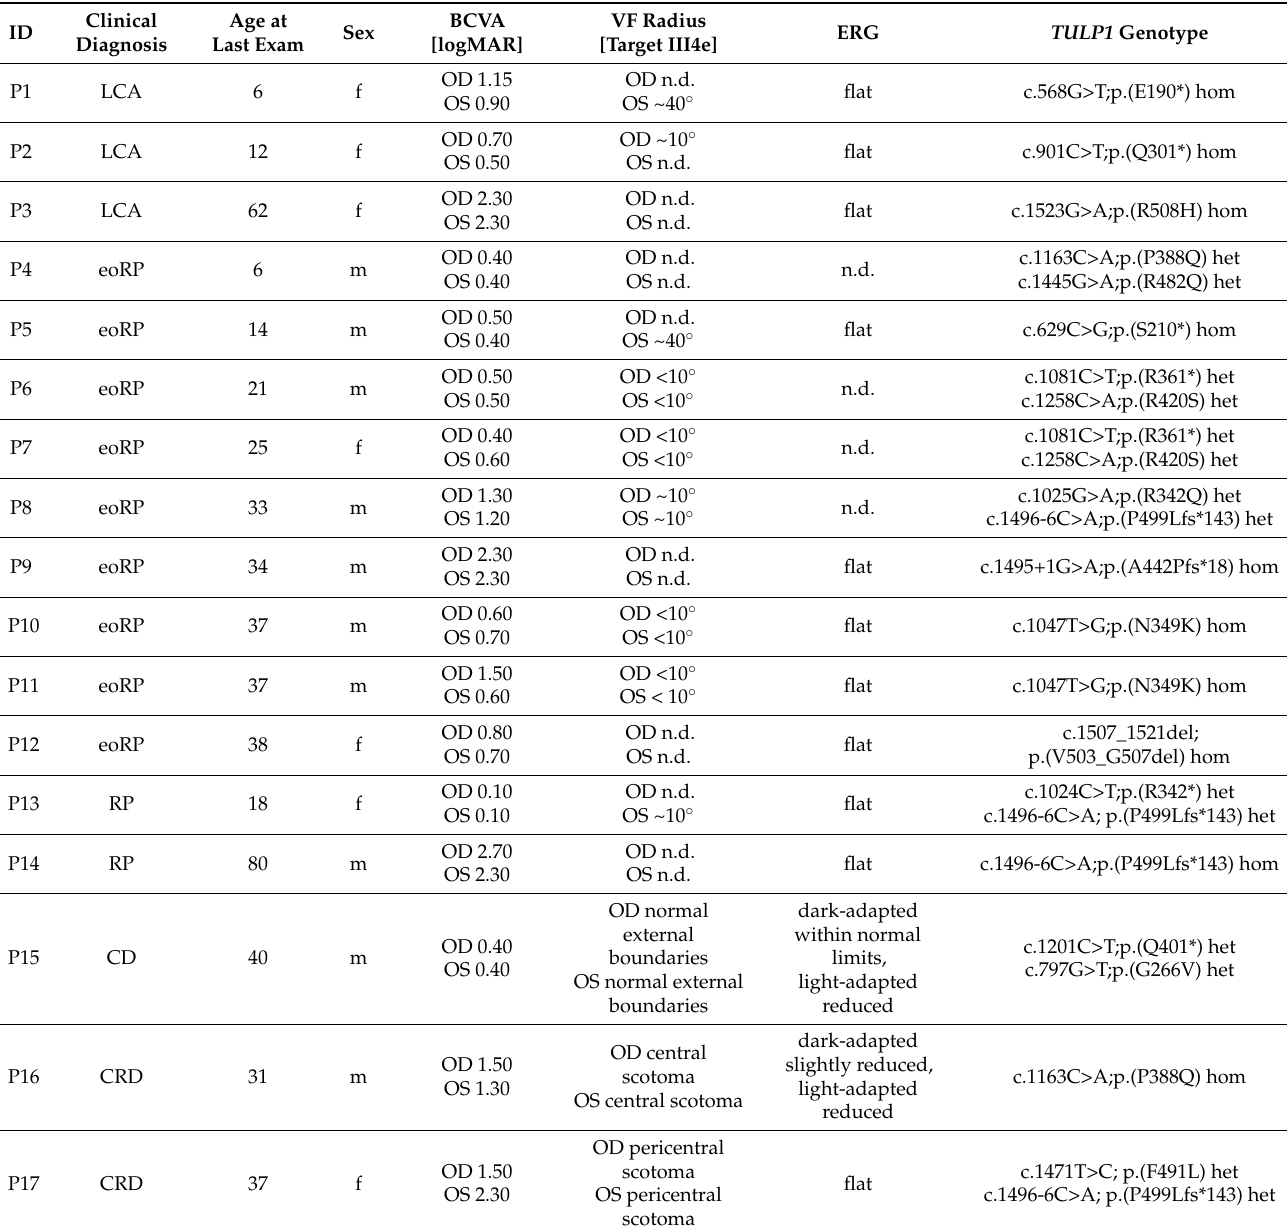
Table 1. Clinical data and genotypes of 17 patients with TULP1 -associated inherited retinal